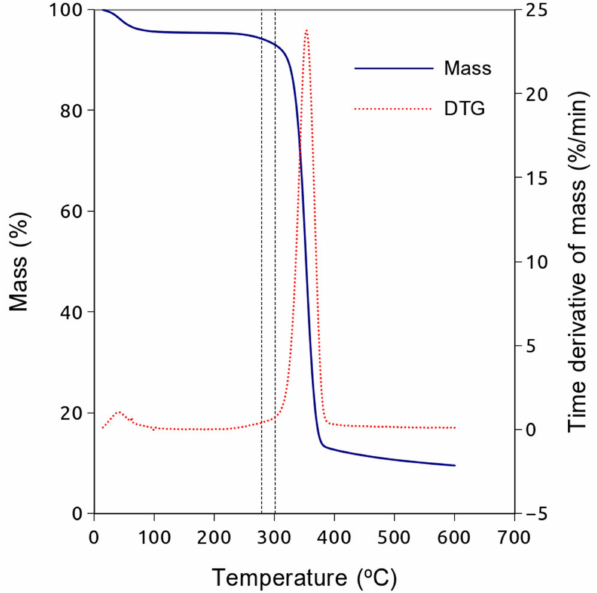
Figure 1. Plots of the thermogravimetry (TG) and derivative thermogravimetric (DTG) curves obtained in ramp. The range of temperature into which isothermal tests are performed is marked with vertical dashed